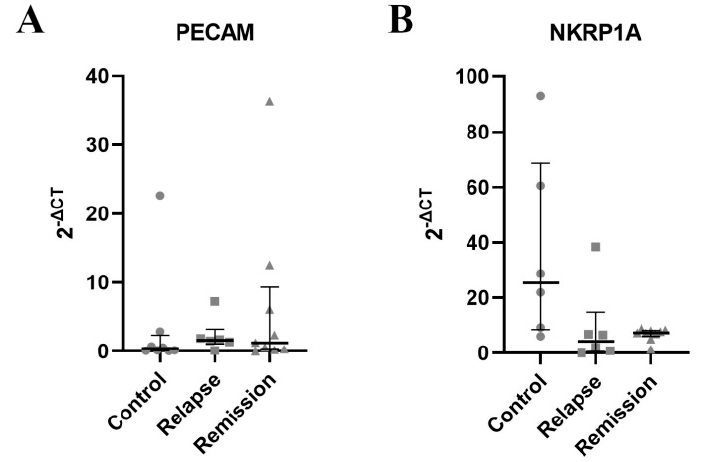
Figure 5. The results for the NKRP1A and PECAM-1 mRNA expression in sorted γδ T cells. A horizontal line with whiskers represents the median with inter-quartile range (IQR). ( A )—expression of PECAM1 mRNA, ( B )—expression of NKRP1A mRNA.